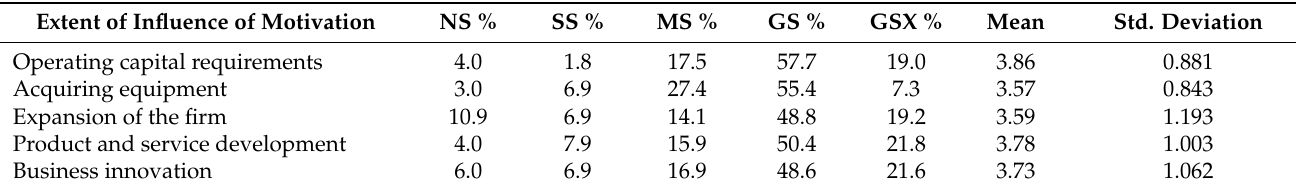
Table 3. Motivation for financing sources.